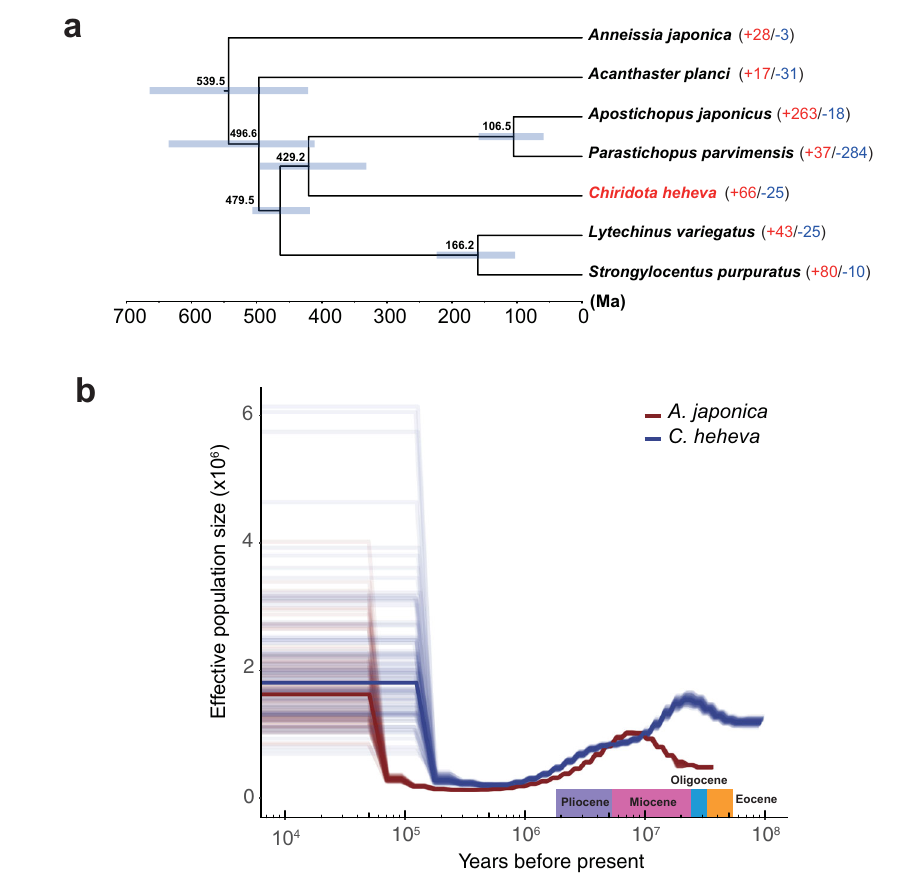
Fig. 3 Evolutionary history of C. heheva . a A species tree of 7 echinoderm species. In total, 988 single-copy orthologs were used to reconstruct the phylogenetic tree. The divergence time between species pairs was listed above each node, and 95% con fi dence interval of the estimated divergence time was denoted as blue bar. The numbers of protein families that were signi fi cantly expanded (red) and contracted (blue) ( P < 0.05) in each species are denoted beside the species names. b Demographic history of C. heheva (blue) and A. japonicus (red). The changes of ancestral-population size of C. heheva and A. japonicus were inferred using the PSMC method. Time in history was estimated by assuming a generation time of 3 years and a mutation rate of 1.0 × 10 − 8